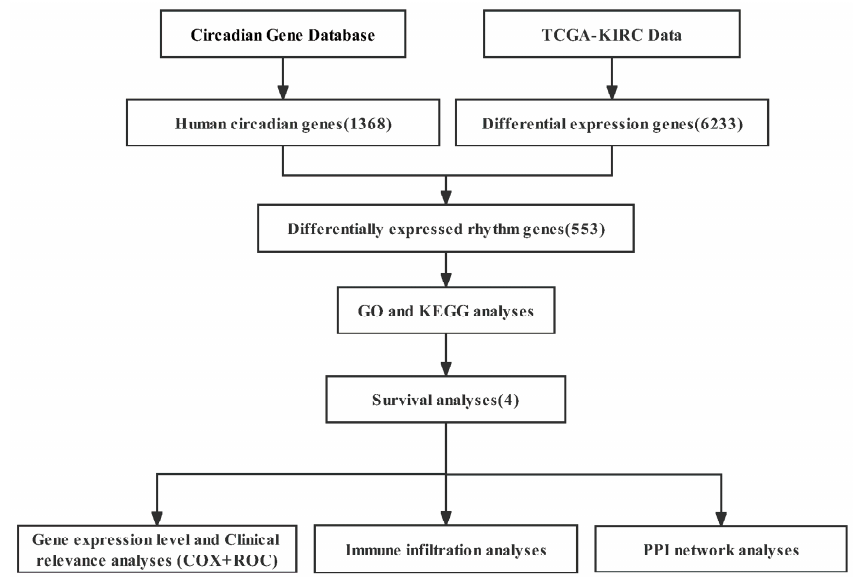
Figure 1. The flow diagram of this study. GO: Gene Ontology; KEGG: Kyoto Encyclopedia of Genes and Genomes.